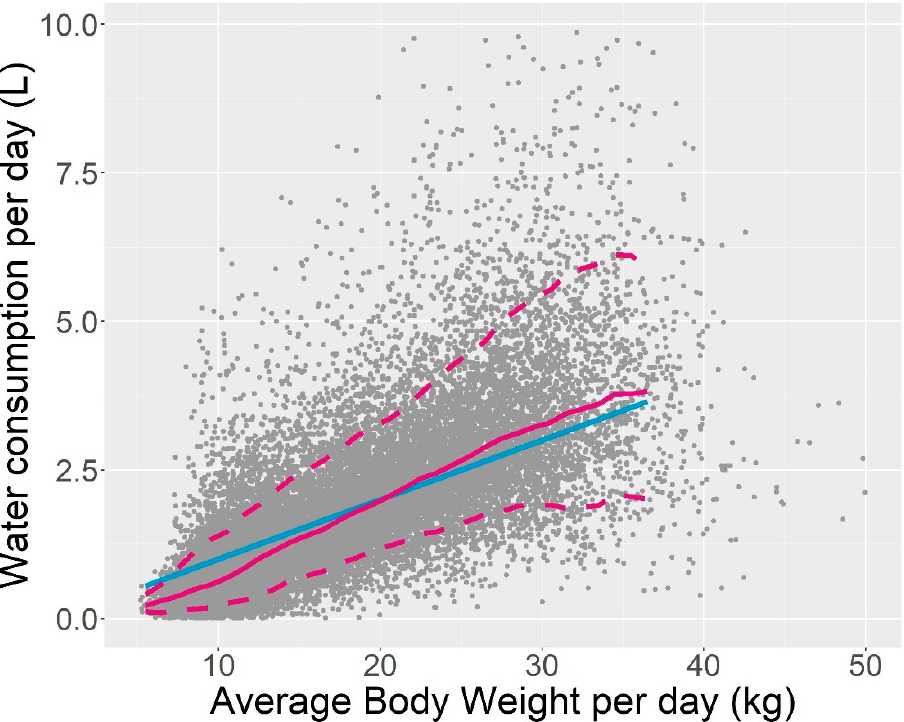
Figure 1. Daily water intake versus body weight for all the piglets and all the days. The blue lines correspond to 0.1 × body weight. The pink curves correspond to the 10%, 50% and 90% quantiles of water consumption for a given weight. For a given body weight, the daily water intake varies by more than 170%. Table 1. Daily water intakes (in liters) according to weight. There is a factor of at least 2.7 (170%) between the volume of water drunk by the 10% heaviest drinkers and the 10% lightest drinkers. This factor reaches 7 (600%) at the beginning of the post-weaning period.